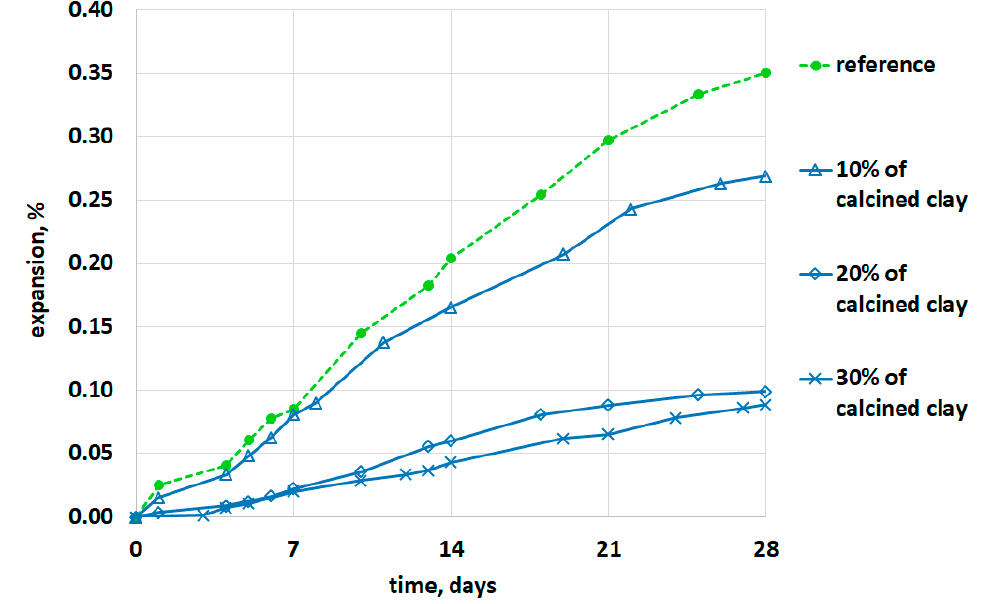
Figure 2. Expansion of mortar specimens with various content of calcined clay as a function of ex- posure time to 1 M of NaOH solution and a temperature of 80 °C. exposure time to 1 M of NaOH solution and a temperature of 80 ◦